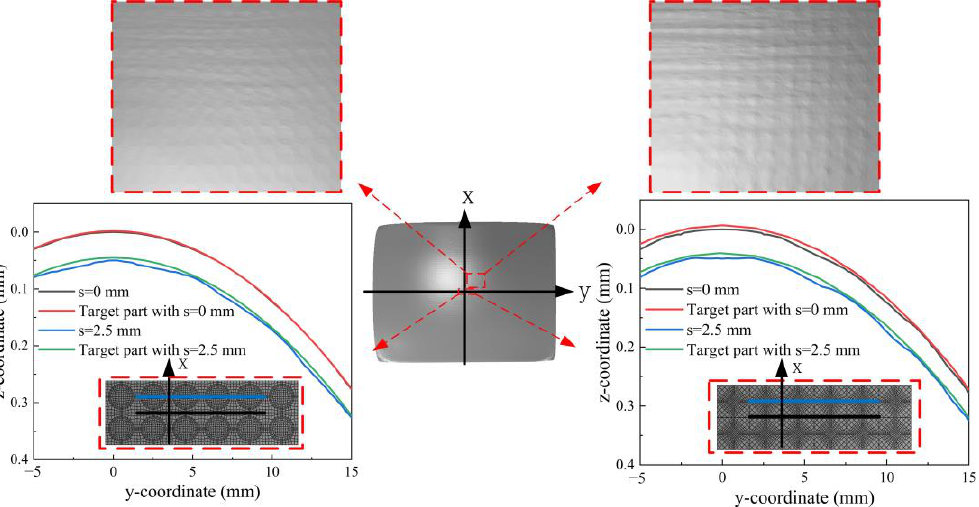
Figure 6. Local straight face effect of lower face sheet of spherical AFSP.